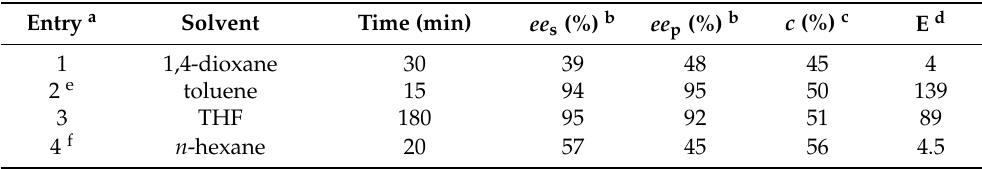
Table 3. Kinetic resolution of rac - 4a via acetylation reaction catalyzed by TLL immobilized on Immobead